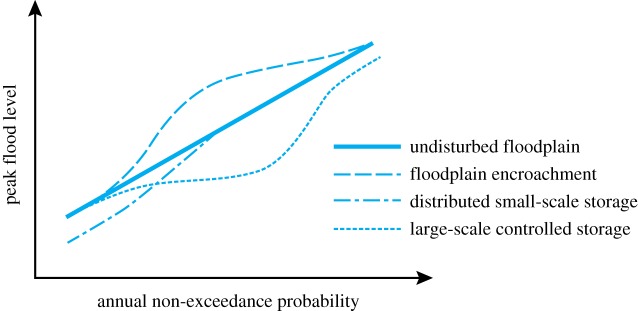
Hypothesized impact of three types of engineering activities on the flood frequency curve. After [6].